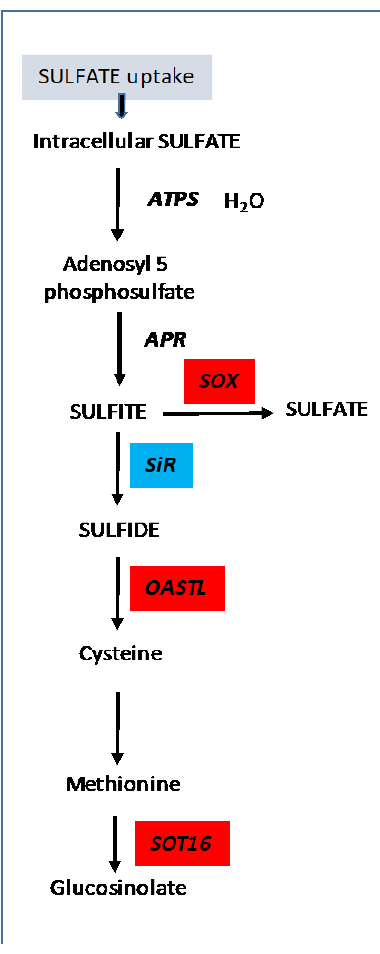
Figure 9. Schematic representation of the effect of atg5 mutation on sulphur assimilation in plants grown under low S conditions. Protein accumulation or depletion in atg5 and atg5.sid2 mutants has been reported by Havé et al. [21]. Proteins overaccumulated in atg5 or atg5.sid2 vs. Col-0 or sid2 are presented in red boxes. Proteins depleted are presented in blue boxes. ATPS, ATP sulphurylase; APR, adenosine 5-phosphosulphate reductase; SiR, sulphite reductase; OAS, O-acetylserine; OASTL, O-acetylserine (thiol) lyase; SOT16, cytosolic sulphotransferase 16.